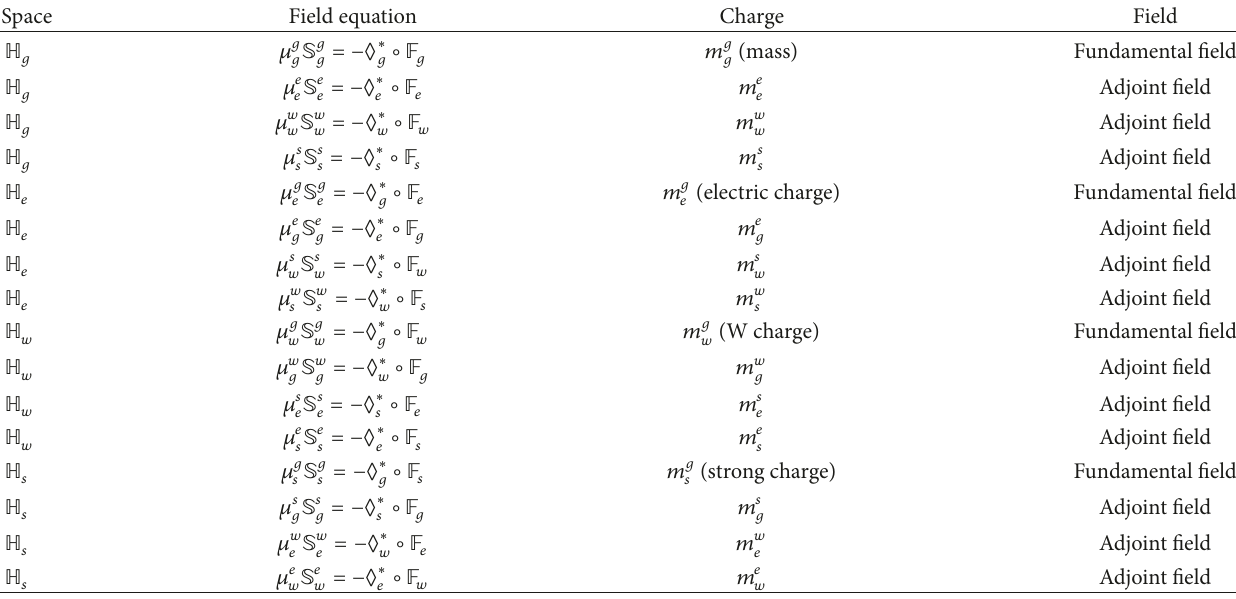
Table 1: The “charges” of fundamental fields and of adjoint fields in the four complex-quaternion spaces, relevant to the complex-sedenion